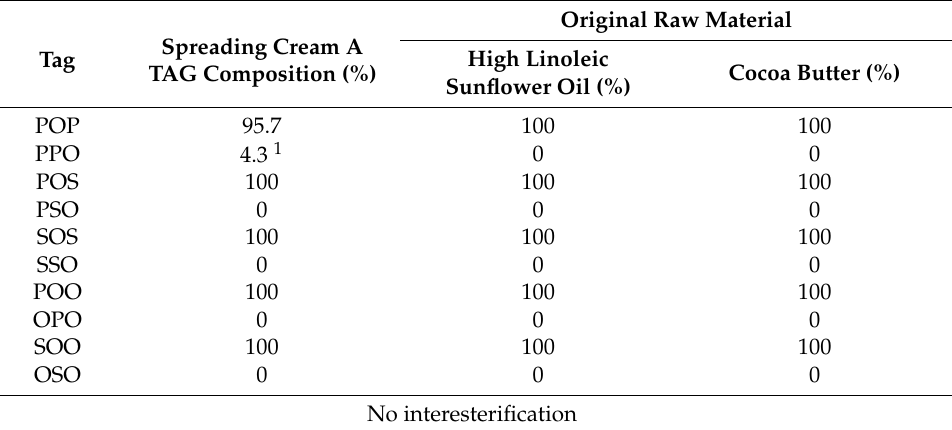
Table 3. Comparison of TAG percent composition between original raw materials and confectionery final products (spreading cream A).